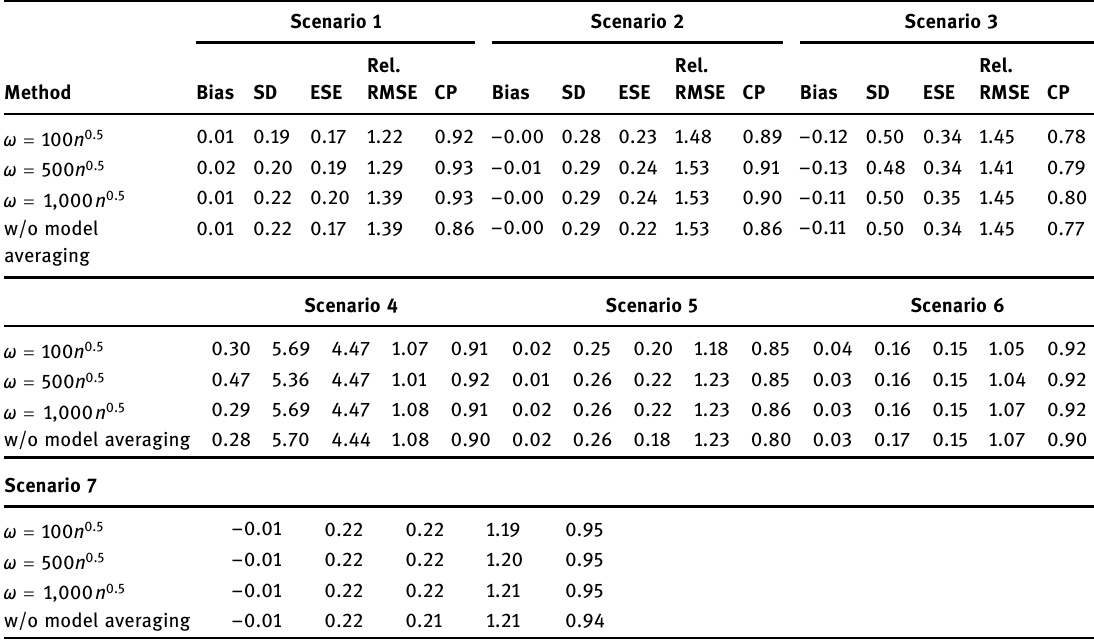
Table A11: Results of simulation Scenarios 1 – 7, with n = 200 for di ff erent implementations of GBCEE Scenario